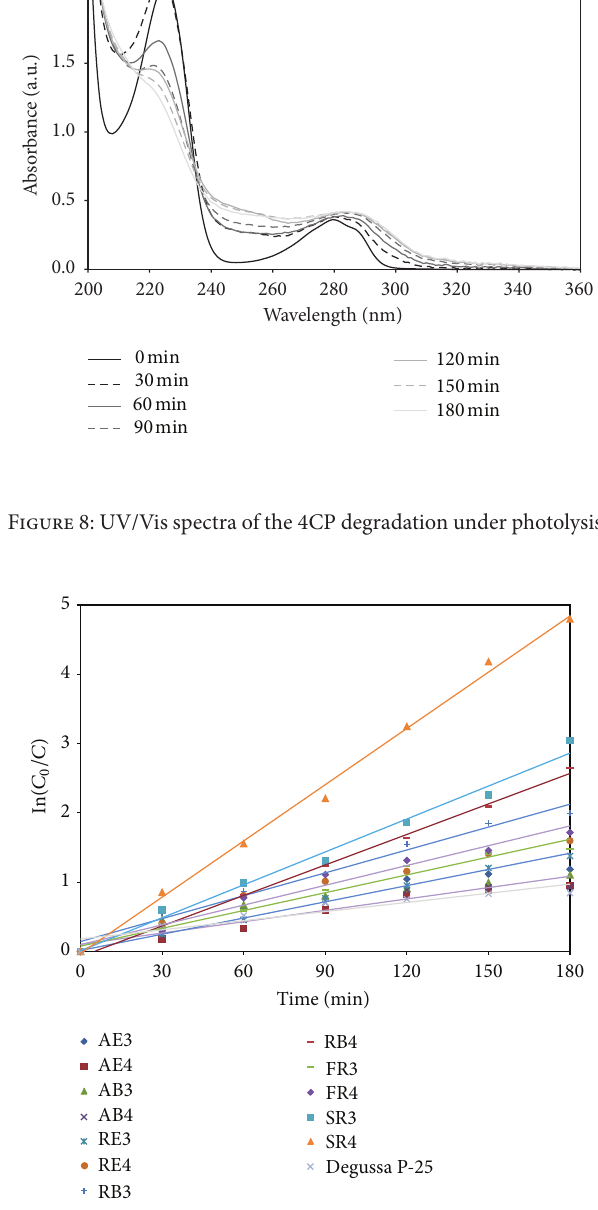
Figure 9: Pseudo-first-order kinetics degradation of 4CP, by the Langmuir-Hinshelwood